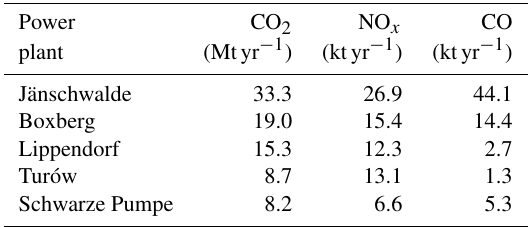
Table 1. Emissions of largest power plants in the model domain according to the TNO/MACC-3 inventory for the year 2011 as used in this